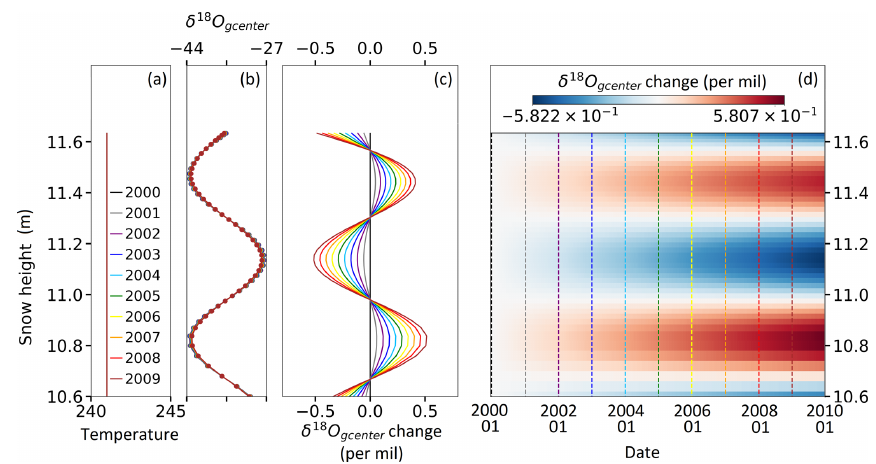
Figure 2. Simulation 1: attenuation of the seasonal δ 18 O gcenter variation caused by diffusion along isotopic gradients in the vapor phase over 10 years (homogeneous and constant temperature of 241K, original signal with a mean value of − 35.5‰ and amplitude of 16‰). (a) Vertical homogeneous temperature profile; (b) δ 18 O profile at the beginning and end of the simulation; (c) deviation of the δ 18 O relative to the original profile for 10 dates; (d) evolution of the deviation to the original profile of δ 18